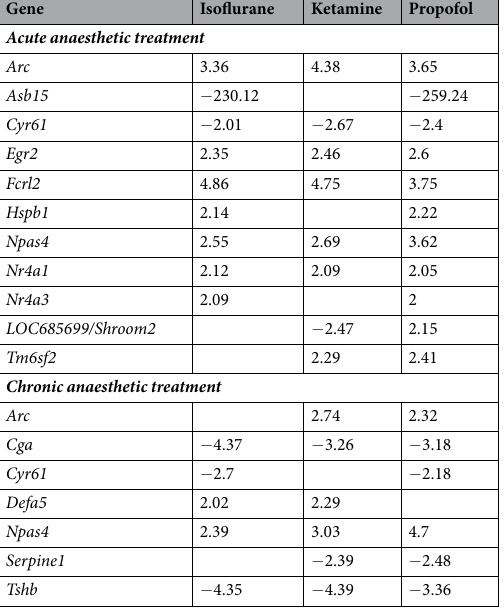
Table 2. Summary of genes significantly altered by 2 or more anaesthetic treatments. Data displayed as fold change/increase or decrease, common genes between both Acute and Chronic